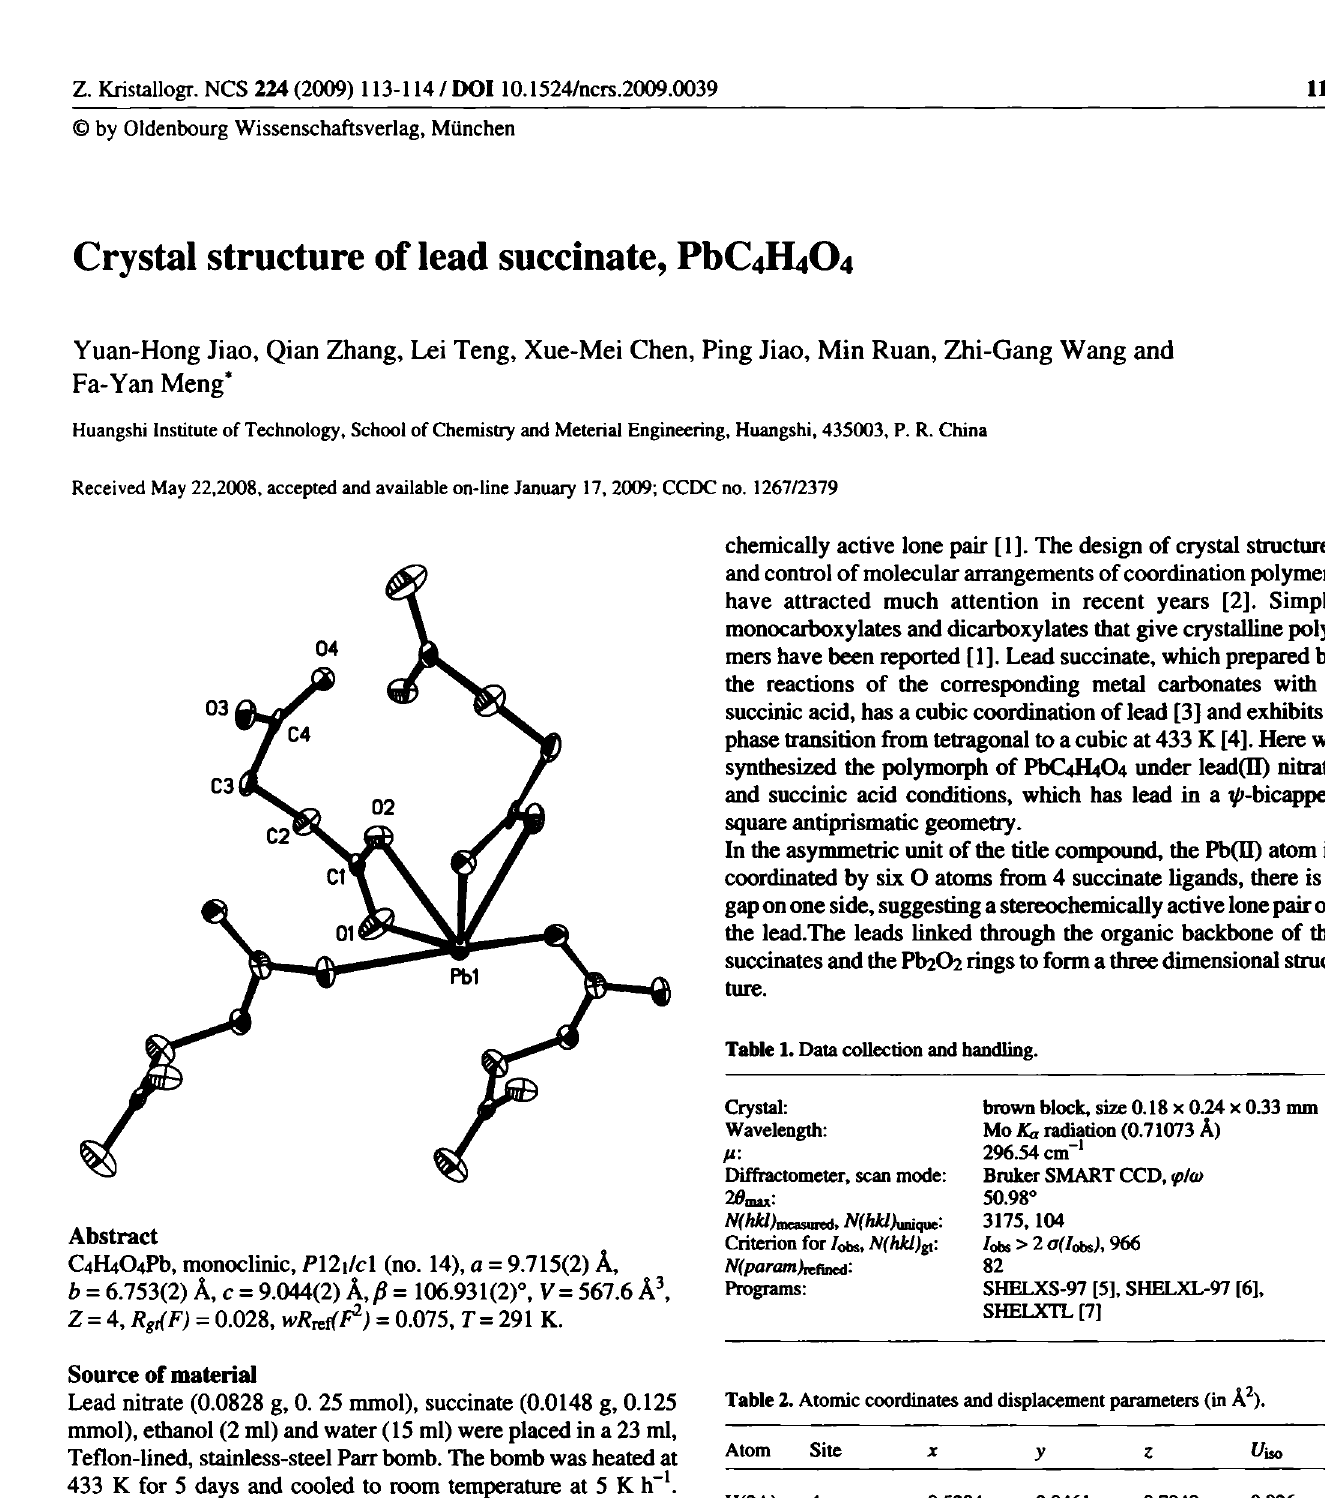
Table 2. Atomic coordinates and displacement parameters (in Â 2